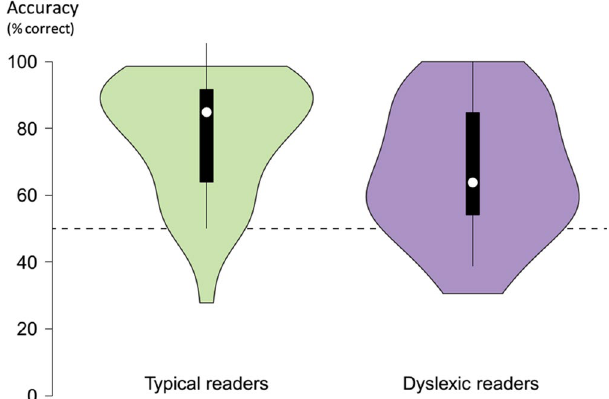
Figure 1. Performance of typical (green) and dyslexic readers (purple) on the visual statistical learning test. Expected chance performance is 50% (dashed line). White discs show the medians. Box limits indicate the 25th and 75th percentiles. Whiskers extend 1.5 times the interquartile range from the 25th and 75th percentiles. Polygons represent density estimates of data and extend to extreme values. This violin plot was created with BoxPlotR 122